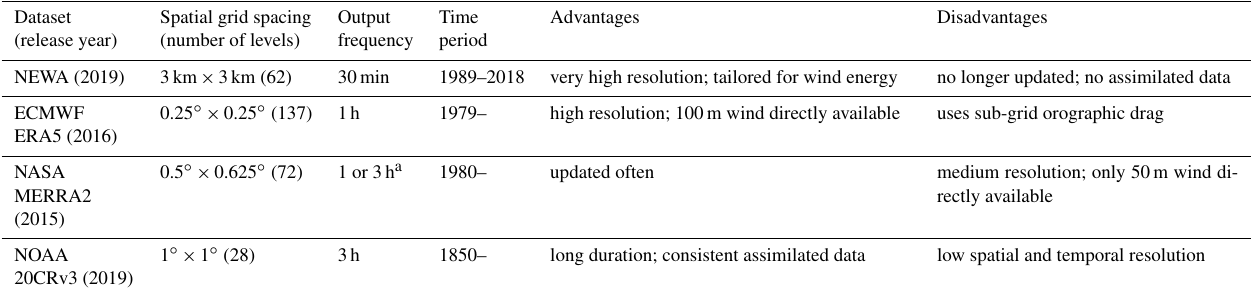
Table 2. Description of the various datasets used in the model evaluation of the historical wind climate.